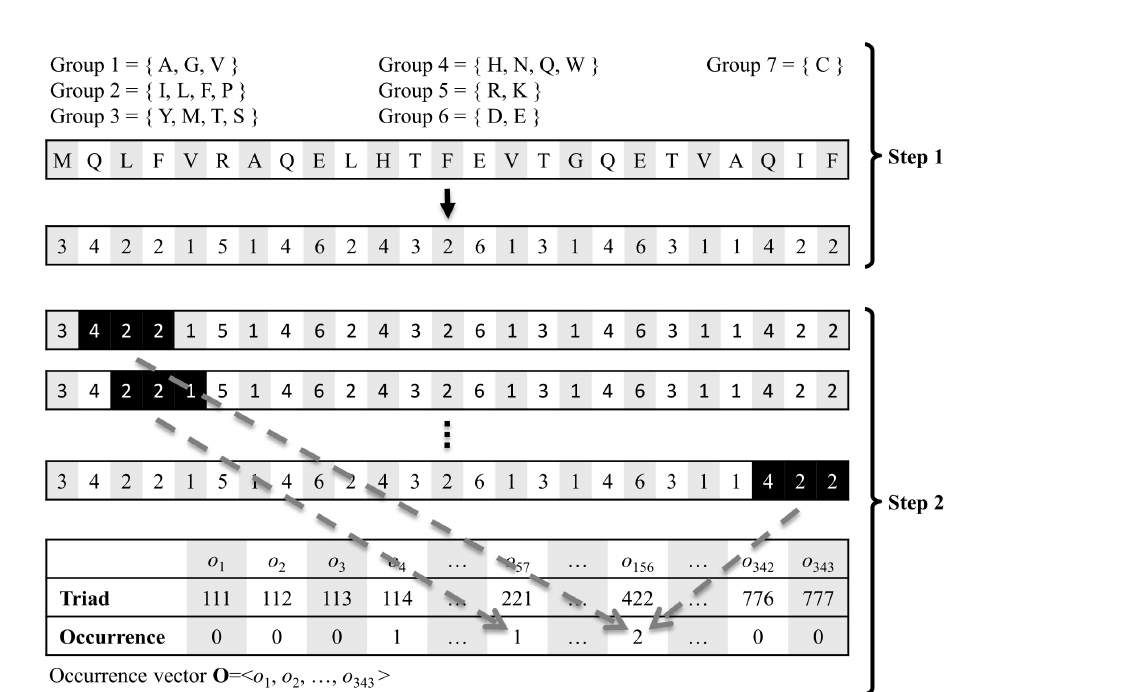
Figure 2. Schematic diagram of encoding a protein sequence into a feature vector. Step 1: Transform the amino acid sequence into the group sequence. Step 2: Scan the group sequence and count the triads in the occurrence vector O . doi:10.1371/journal.pone.0075940.g002 PLOS ONE |